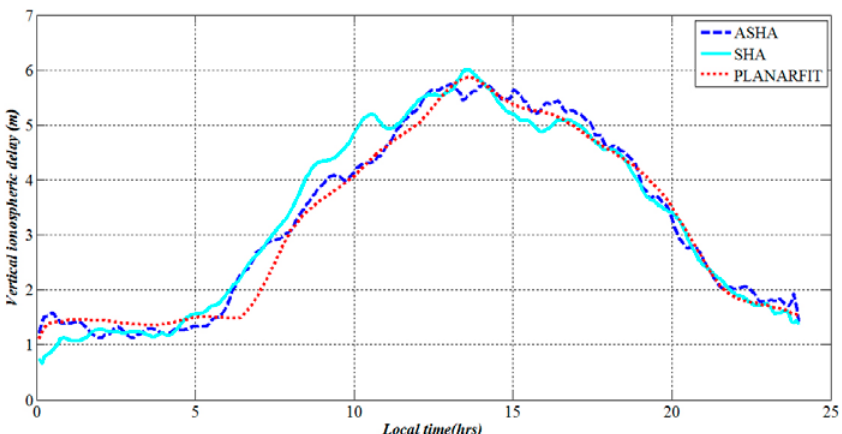
Fig.1. Estimated vertical delay variations on a typical quiet day (July 05, 2004) at IGP location (25° N , 75° E